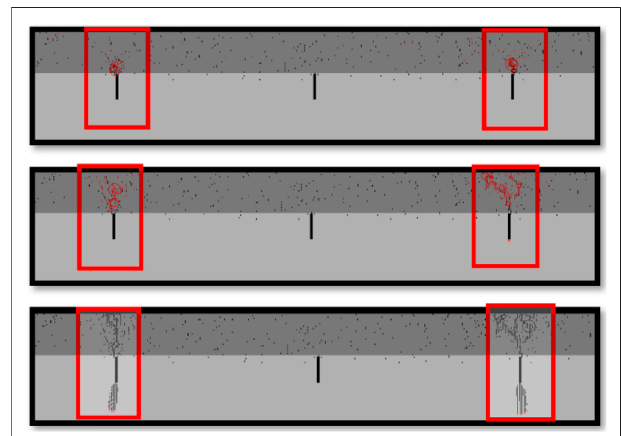
FIGURE 14 | Distribution of AE during formation of re fl ection cracks when S/T = 3.75.